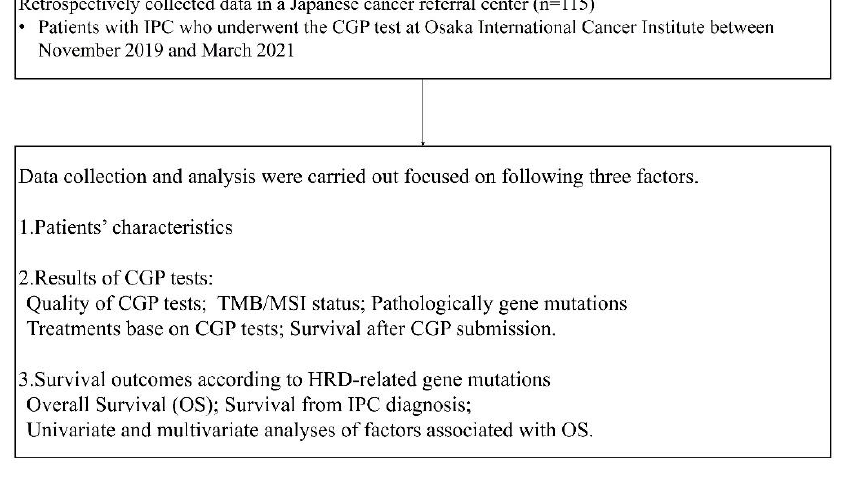
Figure 1. Study design. IPC, incurable pancreatic cancer; CGP, comprehensive genomic profiling; TMB, tumor mutation burden; MSI, microsatellite instability; HRD, homologous recombination de- ficiency.